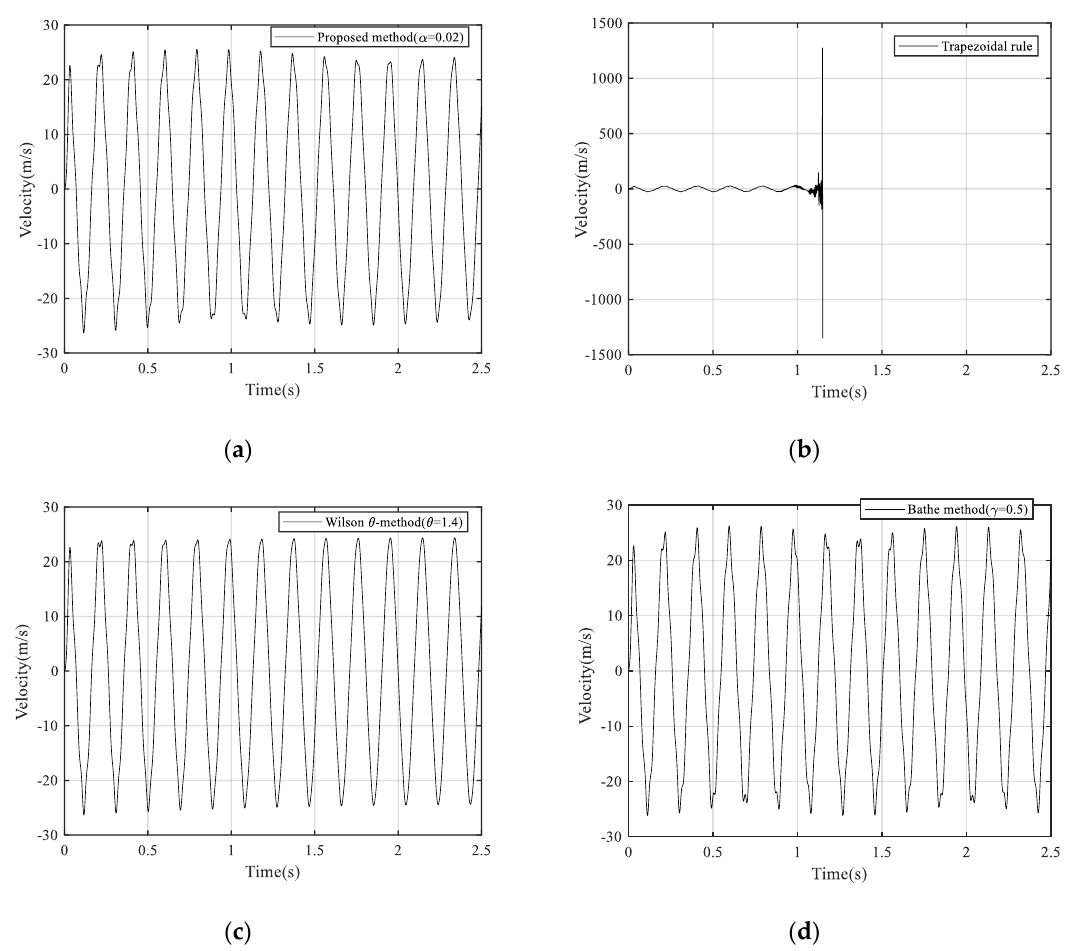
Figure 21. The velocity responses at the free end of the cantilever beam: ( a ) Using the proposed method, ( b ) using the trapezoidal rule, ( c ) using Wilson θ -method, and ( d ) using Bathe method.